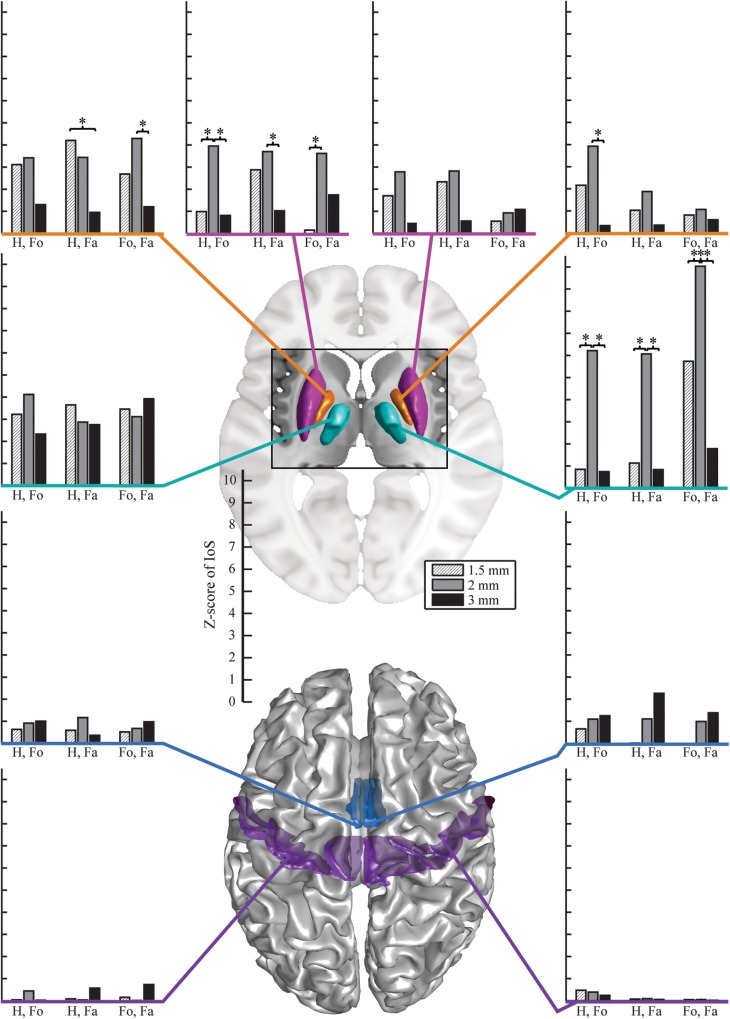
Z-scores of IoS for hand against foot (Ha. vs. Fo.), hand against face (Ha. vs. Fa.) and foot against face (Fo. vs. Fa.) per resolution and ROI, projected on canonical anatomical image in standard space. Bar plots on the left are for left ROIs, bar plots on the right are for right ROIs. Surface renderings of the putamen (magenta), pallidum (orange), motor nuclei of the thalamus (cyan), SMA (mid-tone blue) and M1 (violet). EPI protocols denoted by hatched light gray – 1.5 mm; mid-tone gray – 2 mm, black – 3 mm). Stars indicate significantly different Z-scores (p < 0.05, FDR-corrected).